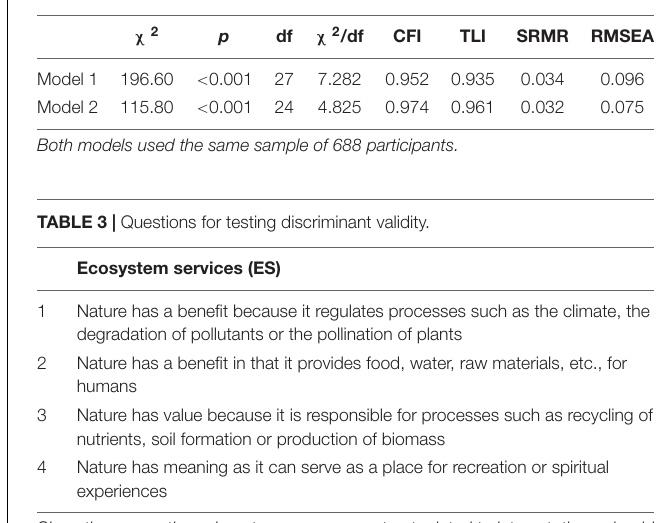
TABLE 2 | Results CFA for models 1 and 2.